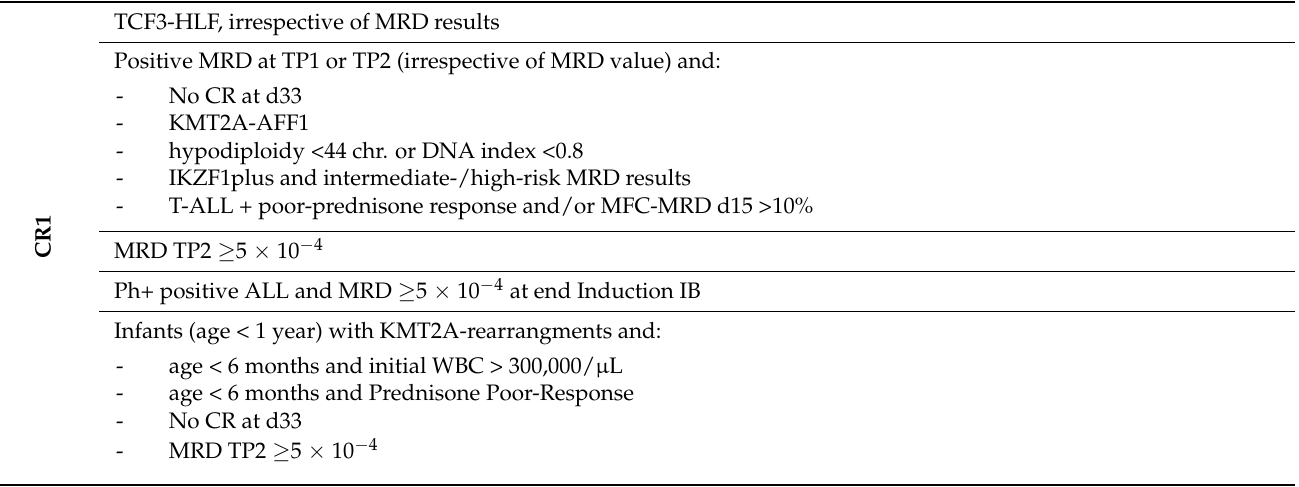
Table 1. HSCT indications in pediatric patients with ALL (adapted from AIEOP-BFM ALL 2017 and IntReALL 2010 protocol). TCF3-HLF, irrespective of MRD